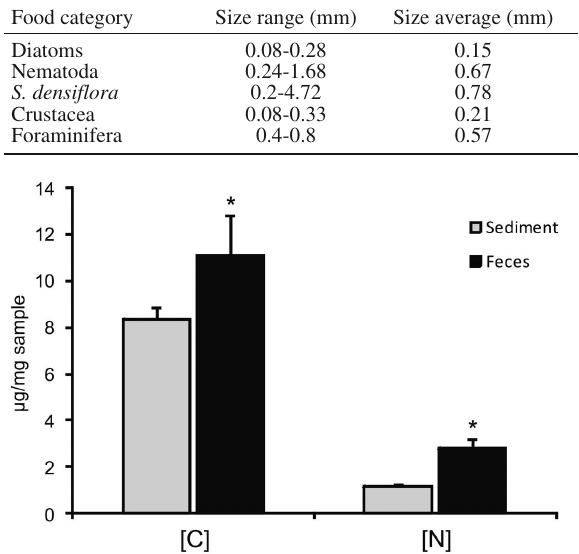
Table 1. – Neohelice granulata. Size range and average of food categories found in sediment and stomach samples after deposit